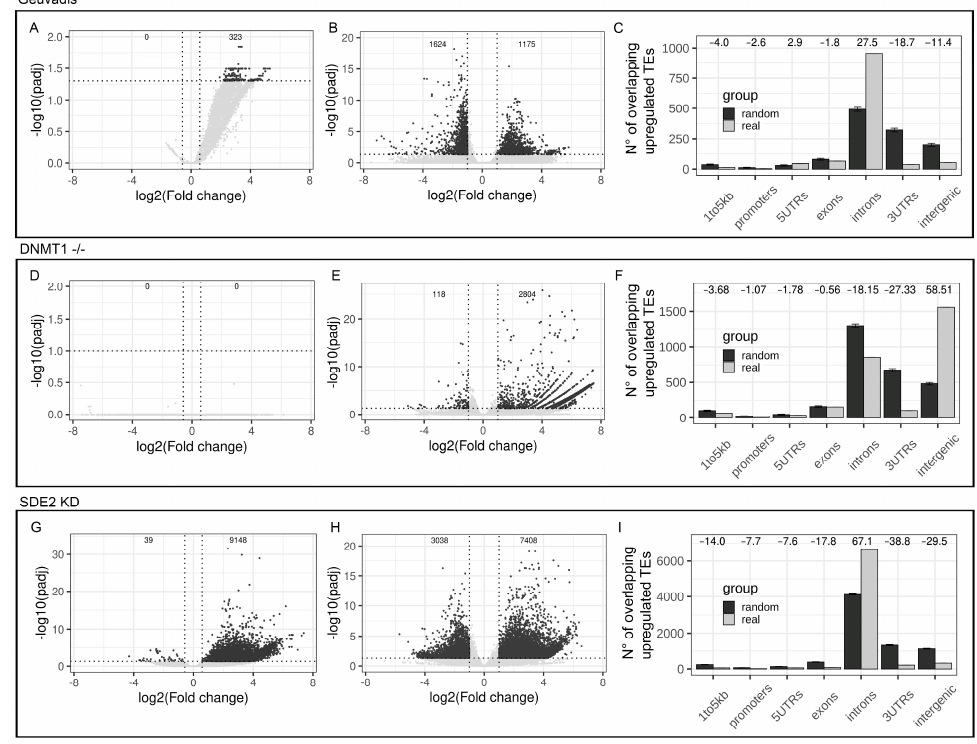
Figure 4. Differential intron retention between groups biases a correct TEs differential expression analysis. ( A ) Volcano plot reporting the number of deregulated introns in IR-High vs. IR-Low samples from Geuvadis dataset. Significant results are reported in dark grey ( B ) Volcano plot reporting the number of deregulated TEs in IR-High vs. IR-Low samples from Geuvadis dataset. Significant results are reported in dark grey. ( C ) Genomic distribution of upregulated TEs (light grey) in IR-High with respect to IR-Low samples compared to the mean of 1000 randomizations (dark grey). Z-score are reported as numbers on the top of the plot. Error bars represent the standard deviation. ( D ) Volcano plot reporting the number of deregulated introns in DNMT -/- samples vs. WT control. Significant results are reported in dark grey. ( E ) Volcano plot reporting the number of deregulated TEs in DNMT -/- samples vs. WT control. Significant results are reported in dark grey. ( F ) Genomic distribution of upregulated TEs